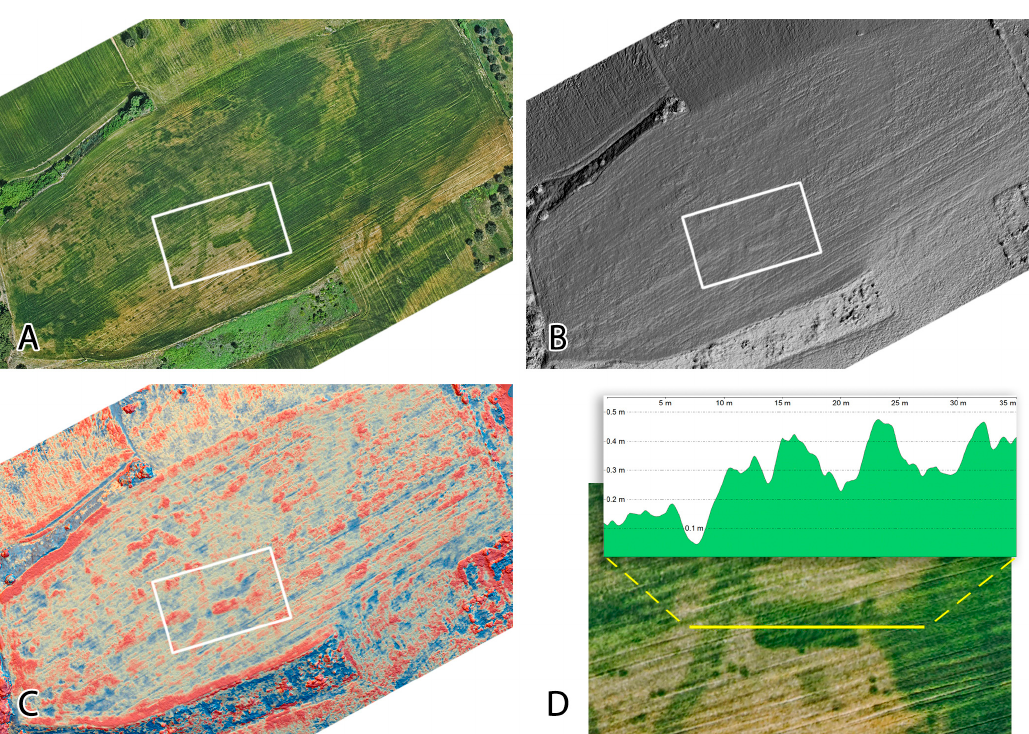
Figure 8. ( A ) Orthophotograph of the Montarice hilltop (Marche, Italy; N 43°25 ′ 18 ″ , E 13°39 ′ 33 ″ — WGS84) showing many vegetation marks. Although no shadow marks are visible, the next three visualisations clearly indicate differences in vegetation height; ( B ) a DSM with artificially created shadow marks; ( C ) a local relief model (annulus kernel, (45 pixels, 75 pixels)) brings out the tiny differences in vegetation height; ( D ) a zoom of the same scene (its extent is indicated in A – C ) with the height of the crops extracted along the uninterrupted yellow line after computing a canopy height model. More details are mentioned in [186].